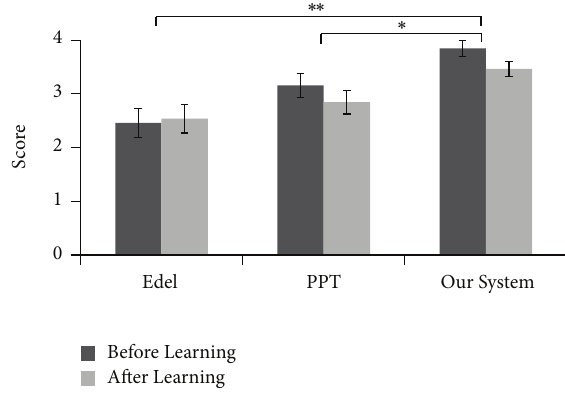
Figure 17: Results for Q5: the average and standard error for each system ( ∗∗ 𝑃 < 0.01 , ∗ 𝑃 < 0.05